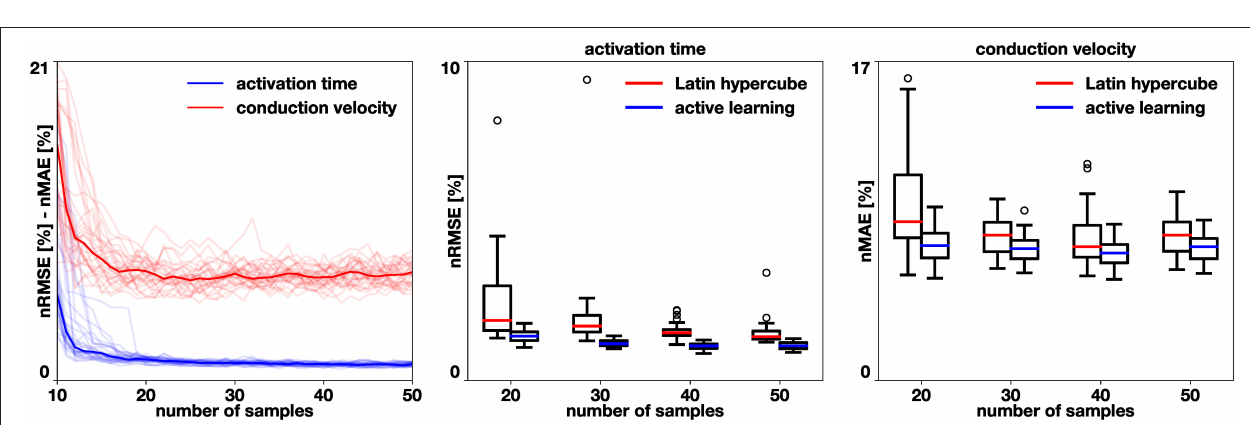
FIGURE 6 | Benchmark problem and active learning. We perform 30 simulations of active learning with different initial samples and compare them against a Latin hypercube design. In the middle and right box plots, we observe a significant reduction in activation time normalized root mean squared error ( p < 10 − 7 ) and in conduction velocity normalized mean absolute error ( p < 0.015) when using the active learning